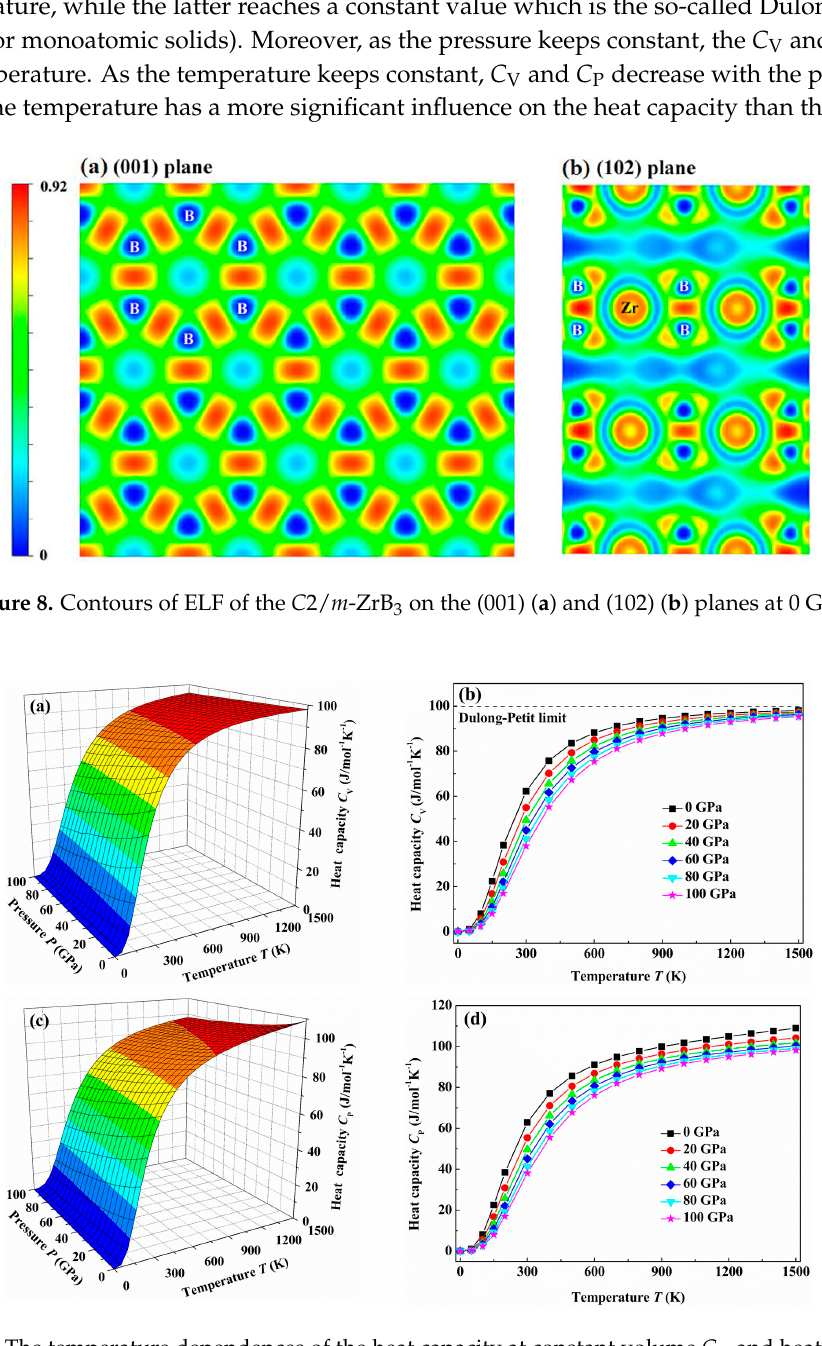
Figure 9. The temperature dependences of the heat capacity at constant volume C V and heat capacity at constant pressure C P at different pressures for the C 2/ m -ZrB 3 : ( a ) C V contours; ( b ) C V - T ; ( c ) C P contours and ( d ) C P - T , respectively.